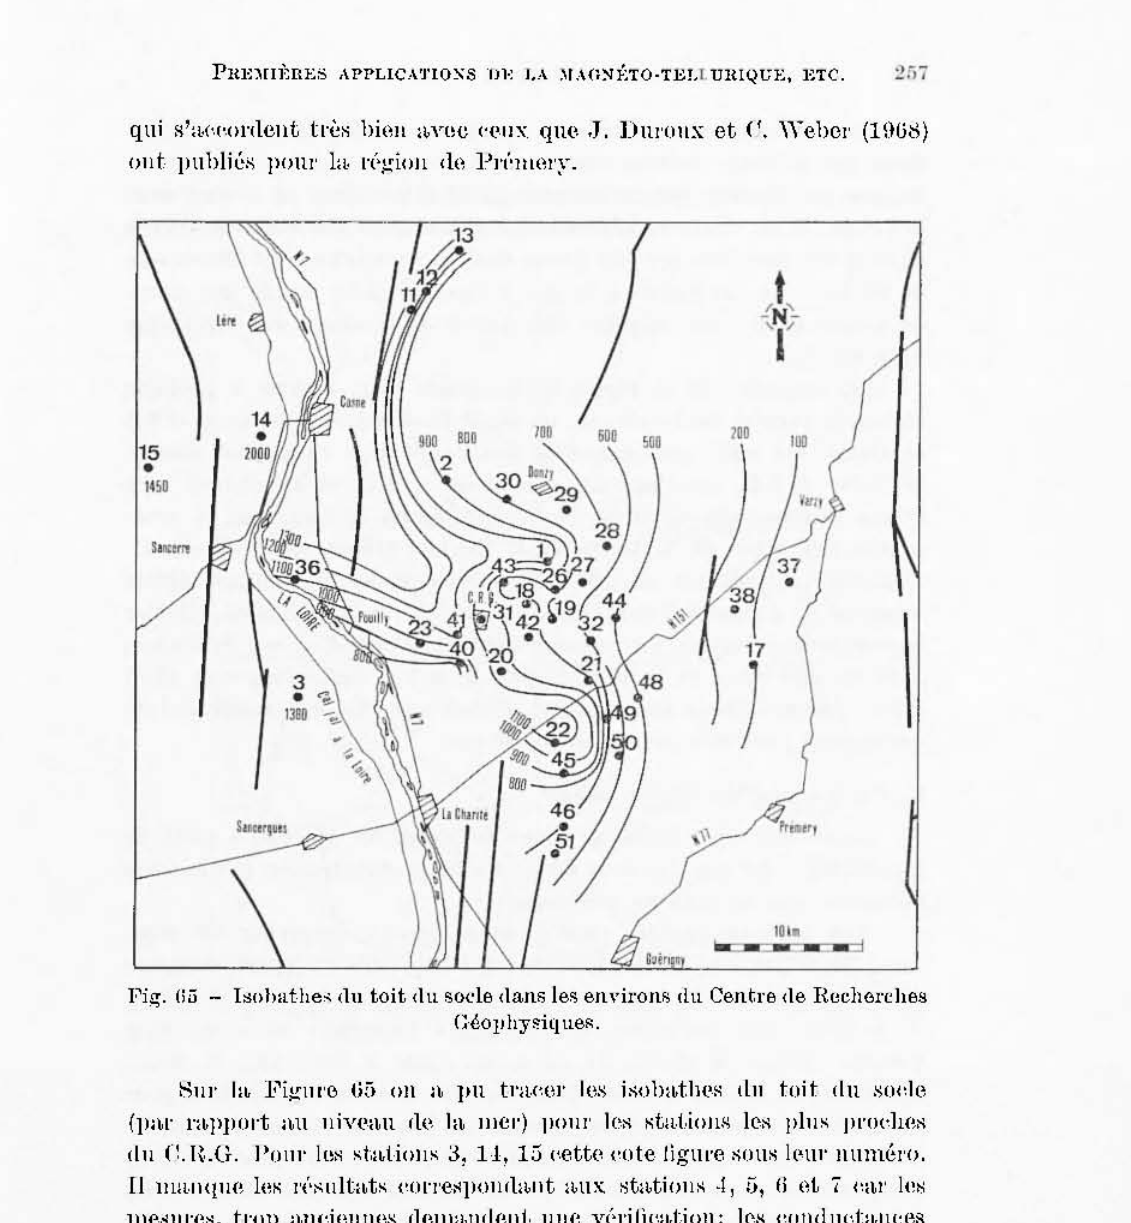
Fig-. O[i - l:;ohathe~ (111 toit (lu sode (lans le~ en\"iron~!lu Centre (le Hecherthes GéoIJhy~iq